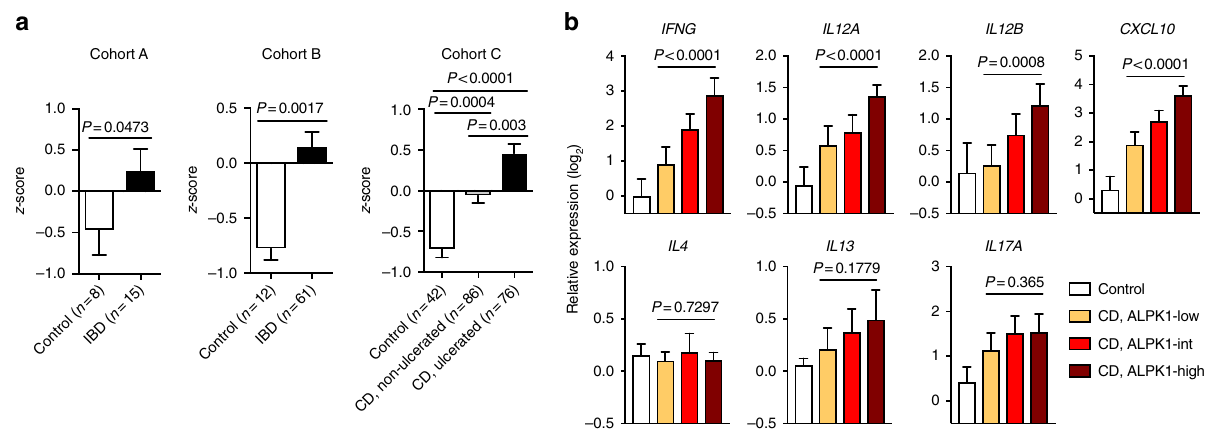
Fig. 6 Alpk1 expression is elevated in in fl amed mucosa of IBD patients and correlates with expression of Th1 signature genes. a ALPK1 mRNA expression in intestinal biopsies of healthy controls or IBD patients from three independent publicly available cohorts described in Materials and Methods (Cohort A, GSE4183; Cohort B, GSE16879; Cohort C, GSE57945). Groups were compared by Mann – Whitney test (cohorts A and B) or Kruskal – Wallis test with Dunn ’ s multiple comparisons tests (cohort C). Bars indicate mean z -scores ± SEM. b RNA-seq gene expression analysis of ileal biopsies from